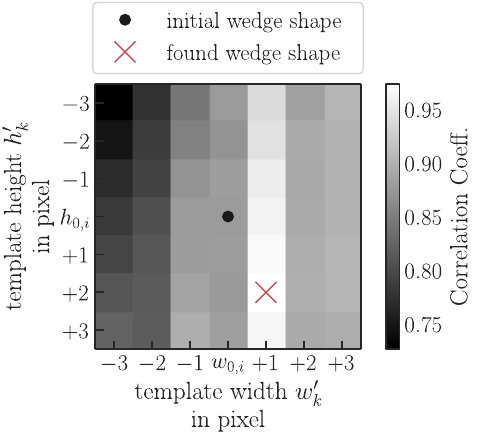
Figure 6. Phase space of correlations for a wedge at position x i , over the template height h (cid:48) width w (cid:48) . The height h 0, i and the width w 0, i are the initial values for the determination of the wedge’s k size. The phase space point ( h 0, i , w 0, i ) is marked with a black dot. The point ( h (cid:48) correlation value is marked with a red